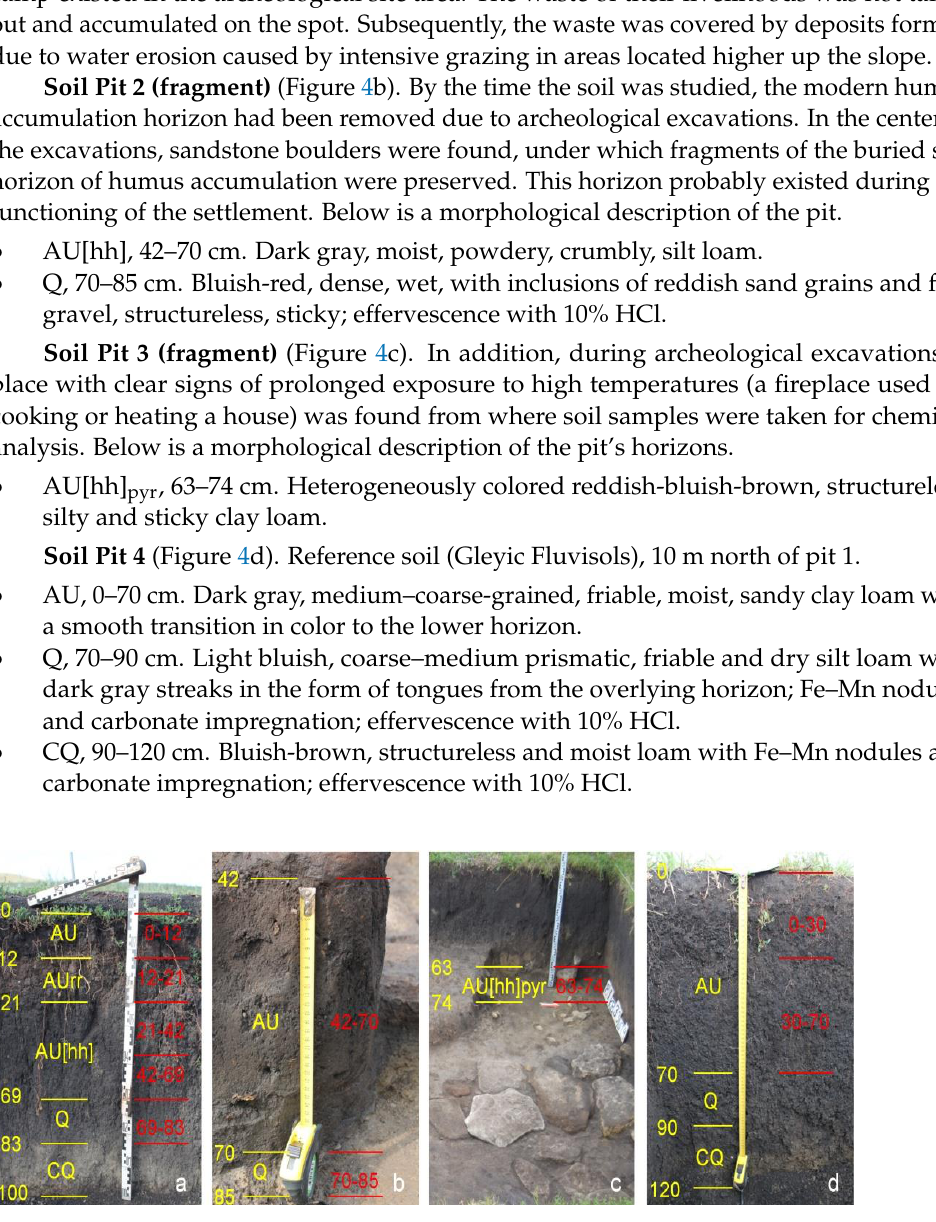
Figure 4. Soil profile views: ( a ) Soil Pit 1; ( b ) Soil Pit 2; ( c ) Soil Pit 3; ( d ) Soil Pit 4. Genetic horizons are in yellow; Sampling depths (cm) are in red.